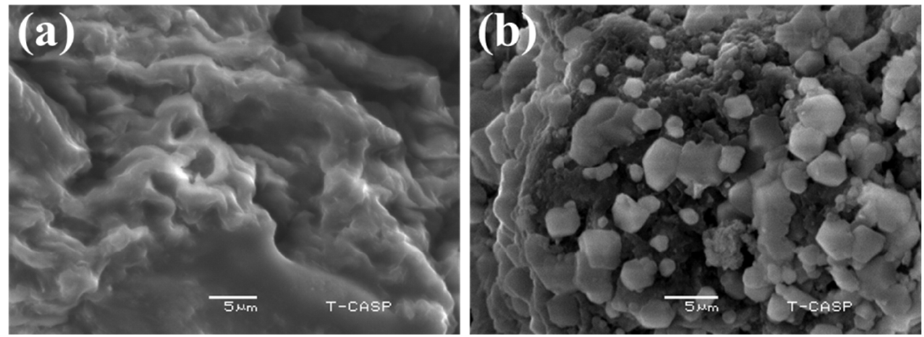
Figure 8. SEM images of ( a ) rhamnoxylan and ( b ) Fe(III) ‐ rhamnoxylan complex.